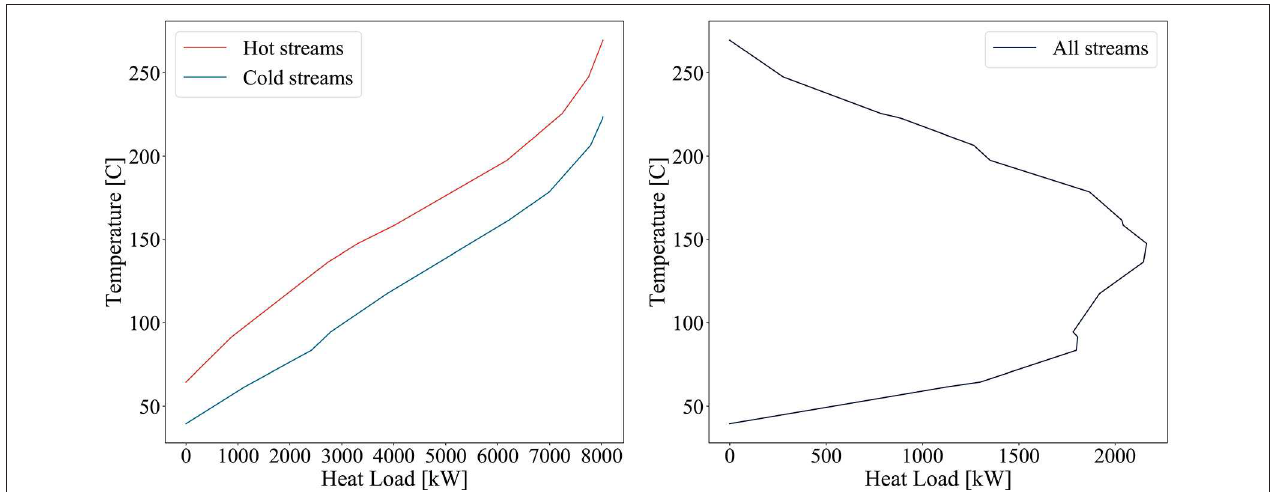
FIGURE 1 | Example of a composite curve (Left) and a grand composite curve (Right) , using data from Papoulias and Grossmann